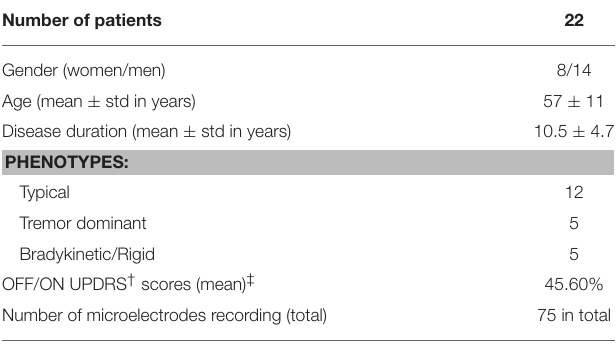
TABLE 1 | Clinical characteristics of the PD patients included in this study. Number of